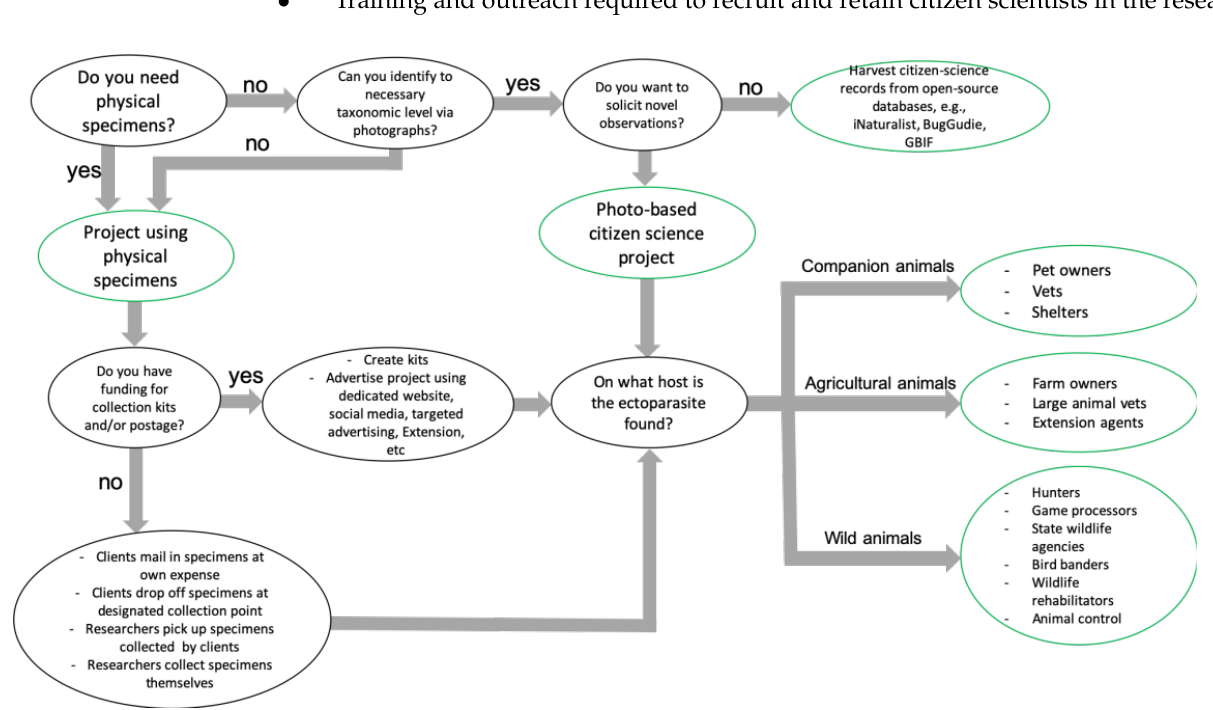
Figure 1. A flowchart of considerations and questions related to ectoparasite collection, animal populations, and target audiences while planning a citizen science program focused on ectoparasite sampling from animal hosts.